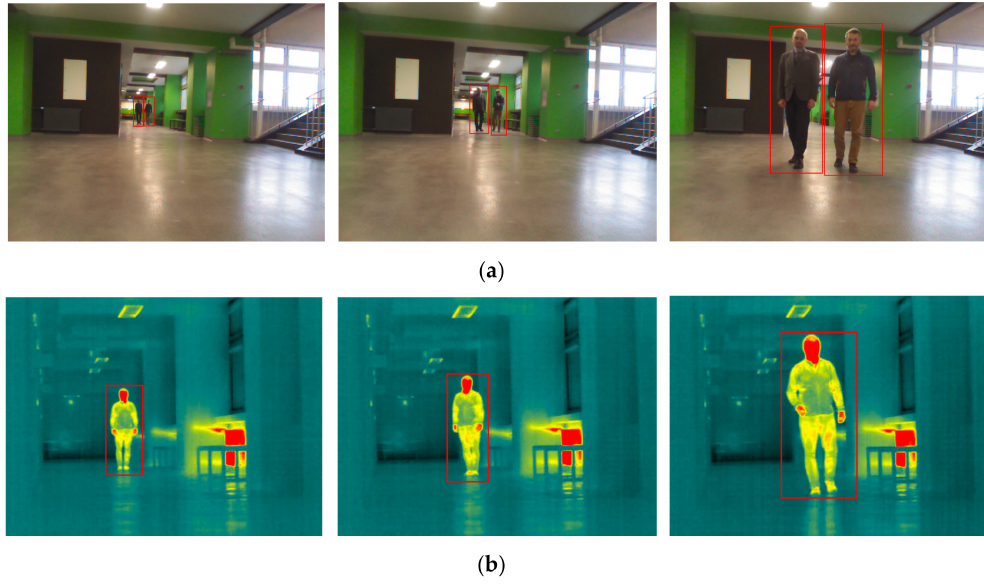
Figure 8. Images with checked ROIs: ( a ) vision images, and ( b ) infrared images.